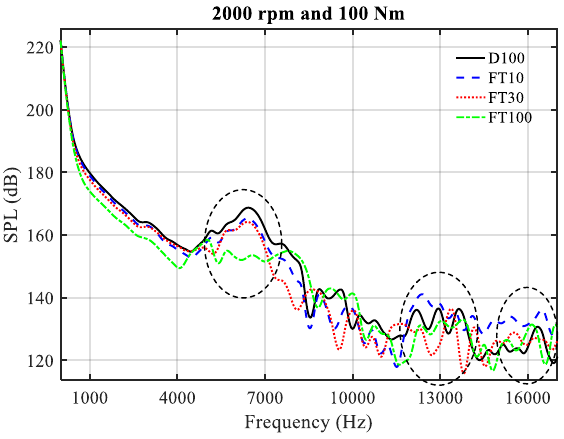
Figure 4. SPL spectra for different fuels.